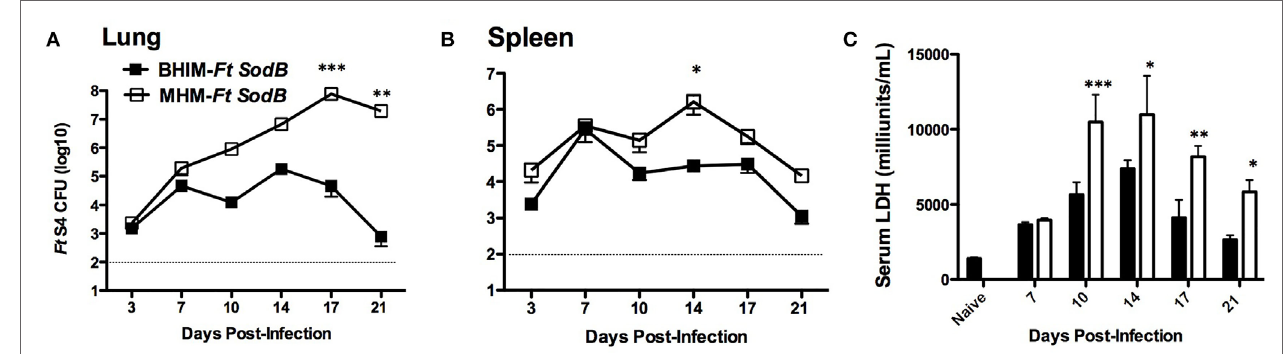
FigUre 4 | Enhanced protection against Francisella tularensis ( Ft ) SchuS4 challenge in brain-heart infusion medium (BHIM)- Ft sodB- vaccinated mice is associated with reduced bacterial burden and tissue damage. C57BL/6 female mice were immunized i.d. with either 50 µl of 1 × 10 3 CFU of BHIM or Mueller-Hinton medium (MHM)- Ft sodB on day 0 and boosted i.n. on day 21 with 20 µl of 1 × 10 3 CFU of BHIM or MHM- Ft sodB . Mice were then challenged i.n. on day 42 using MHM- Ft SchuS4. Bacterial burdens from lung (a) and spleen (B) were determined on days 3, 7, 10, 14, 17, and 21 post-challenge. The values represent the average bacterial count of three mice sacrificed at each time point ± SD and are from a single experiment. Similar results were obtained in two independent experiments. Serum lactate dehydrogenase concentrations (c) were quantified on indicated days post-challenge. Each bar represents mean ± SE (error bar) of two independent experiments with a total of six mice per group. * P < 0.05, ** P < 0.01, and *** p <